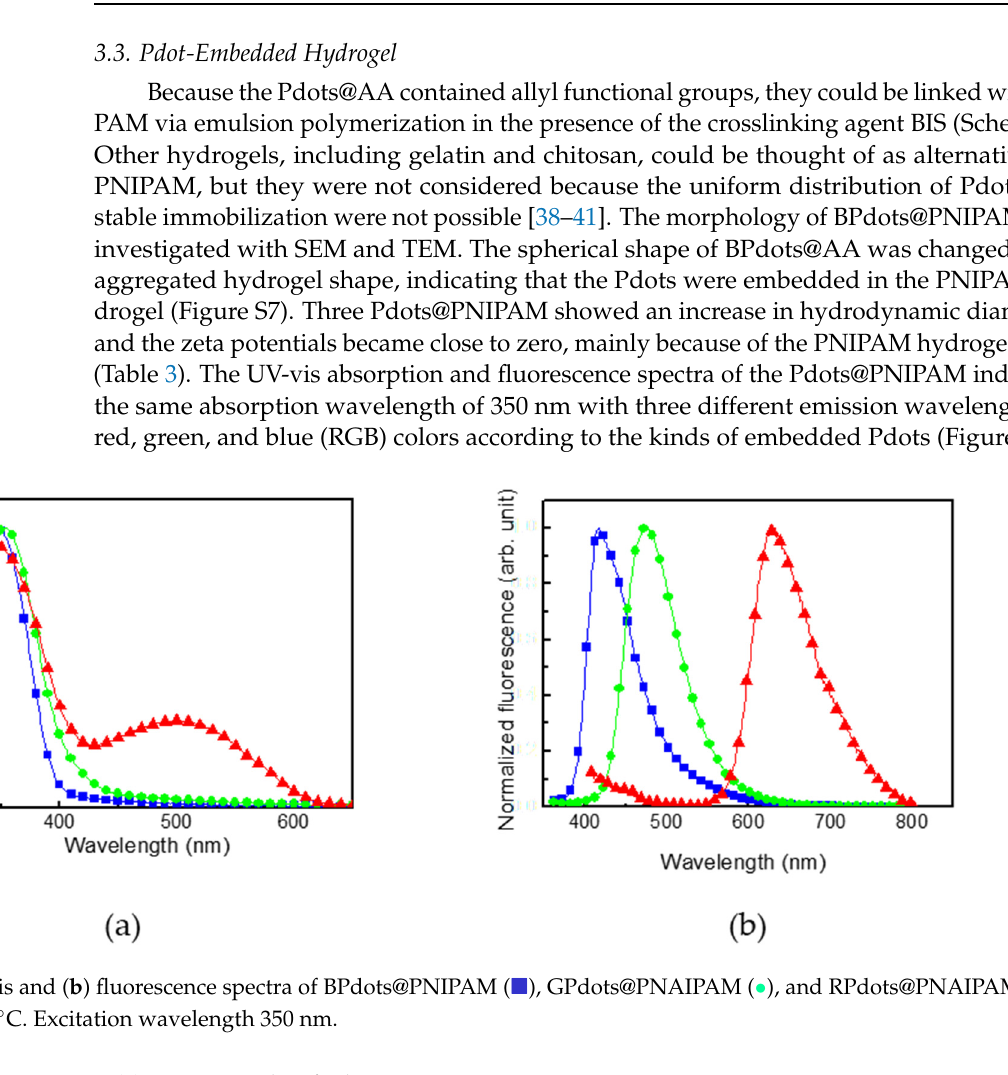
Table 3. DLS results of Pdots@PNIPAM.